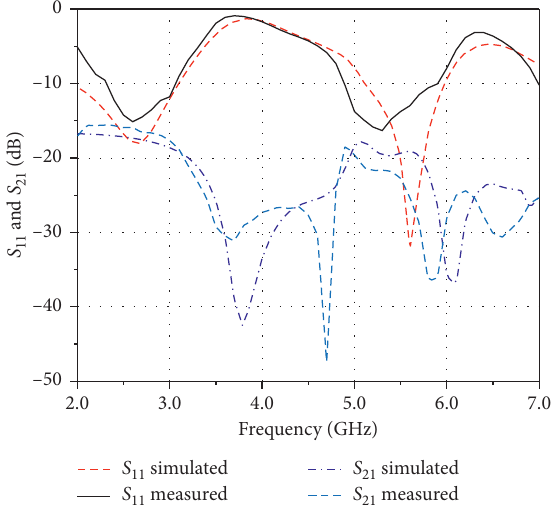
Figure 6: Simulated and measured S-parameter of the proposed antenna.